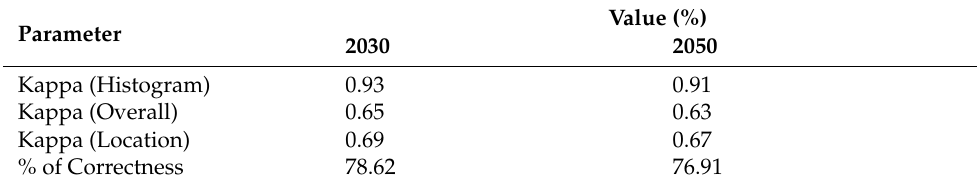
Table 9. Model validation’s Kappa index (Simulated 2030 and